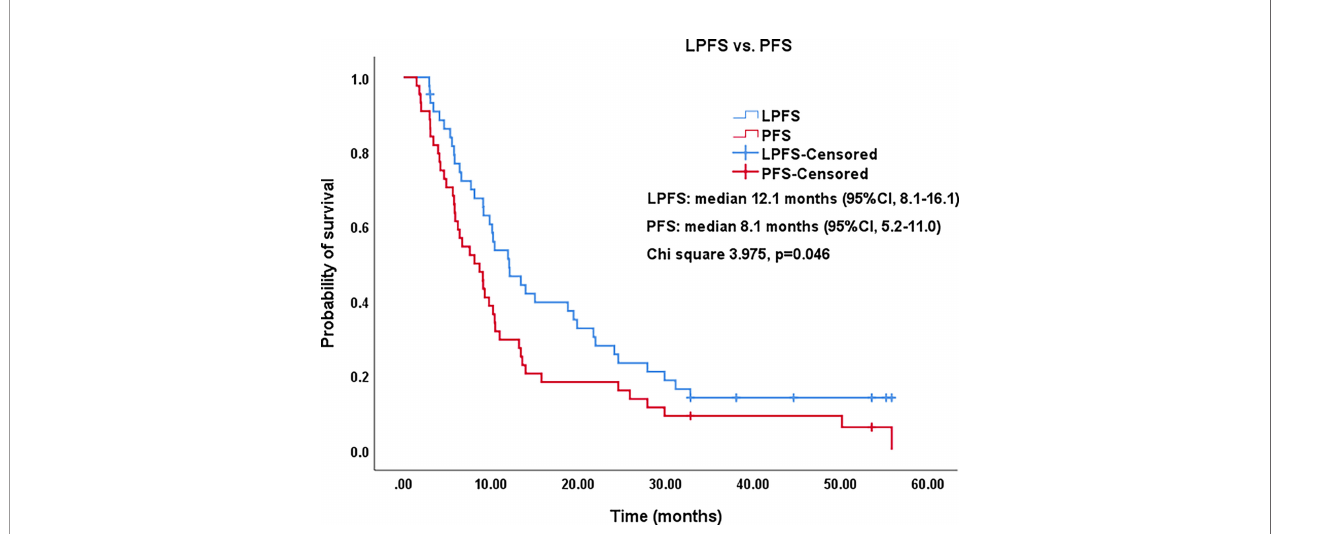
FIGURE 3 | Kaplan – Meier survival curves of LPFS versus PFS. The 1-,2-, and 3-year PFS rates were 29.5%, 18.2%, and 9.1%, respectively. The 1-,2-, and 3-year LPFS rates were 51.2%, 27.9%, and 13.6%, respectively. LPFS, local progression-free survival; PFS, progression-free survival; CI, con fi dence